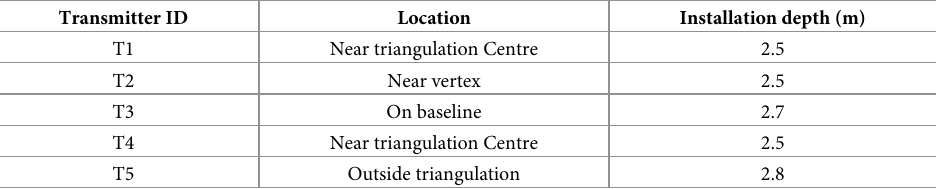
Table 1. Summary of deployment information for the five transmitters employed during stationary